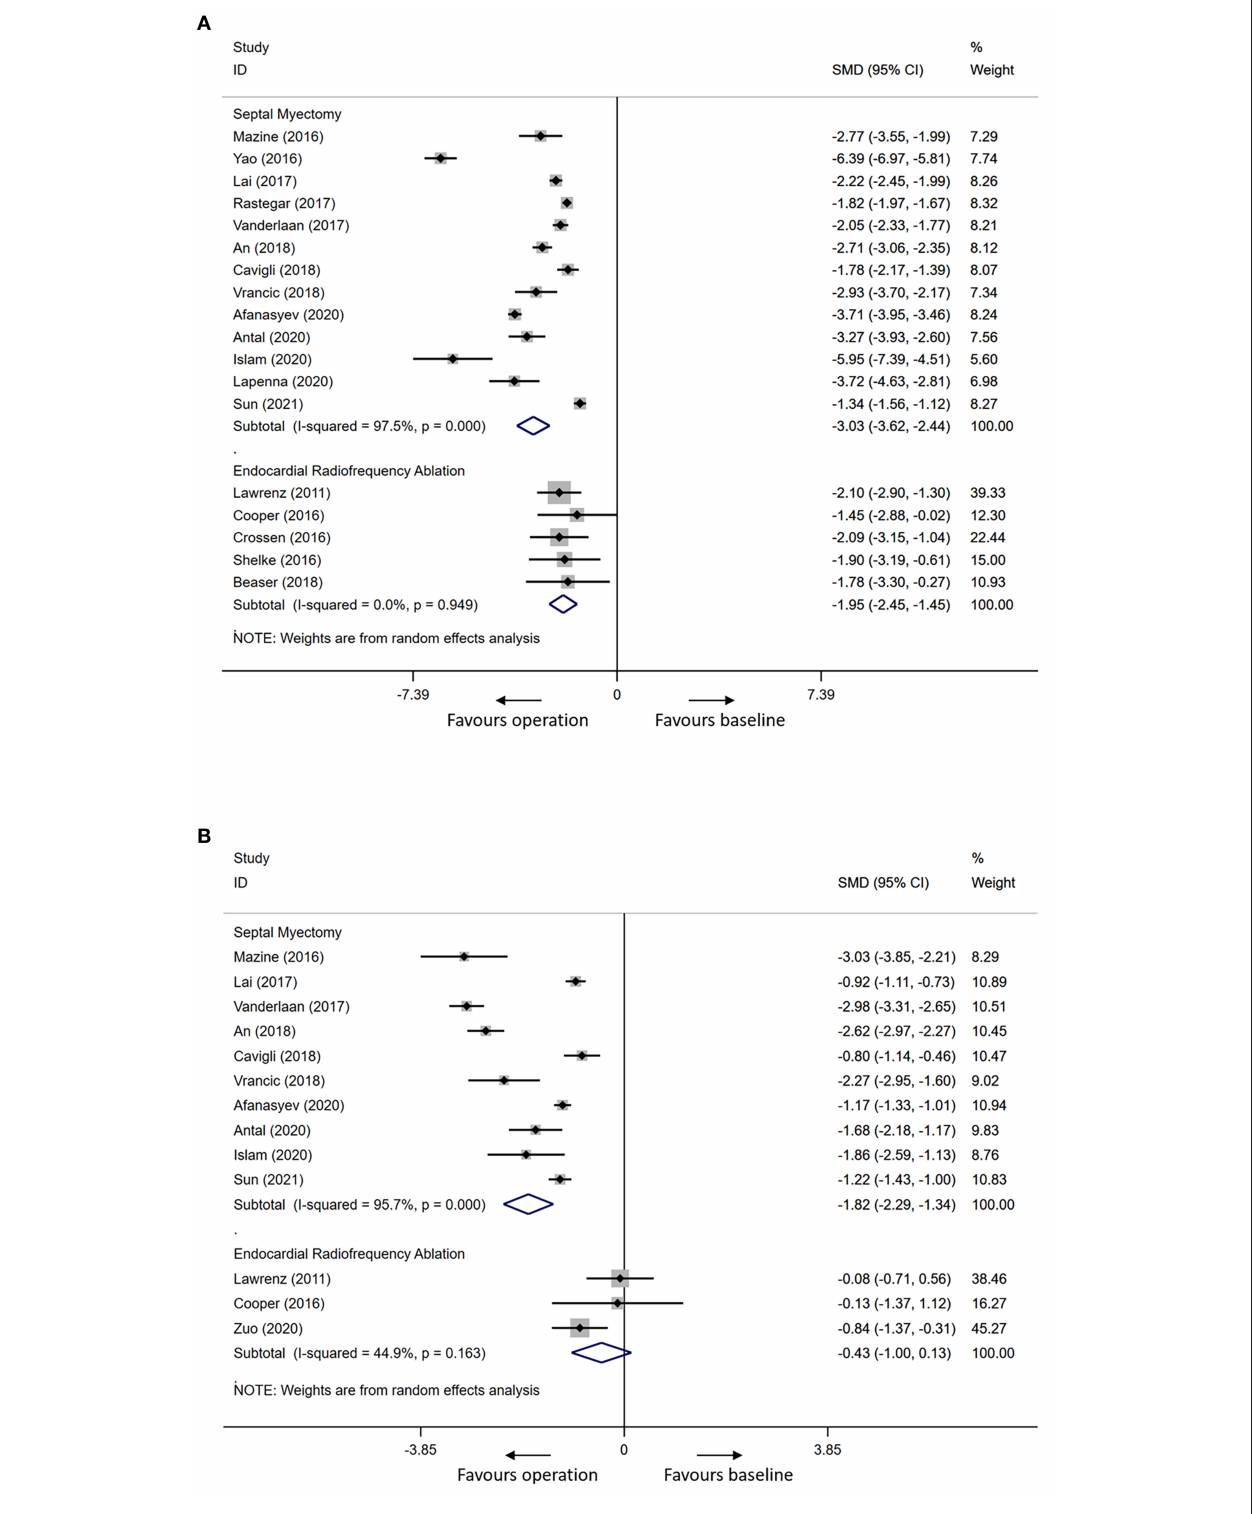
FIGURE 2 | Forest plots for the primary outcomes in adults after septal myectomy or endocardial radiofrequency ablation. (A) Forest plot for the resting LVOTG. (B) Forest plot for the interventricular septal thickness. LVOTG, left ventricular outflow tract gradient.